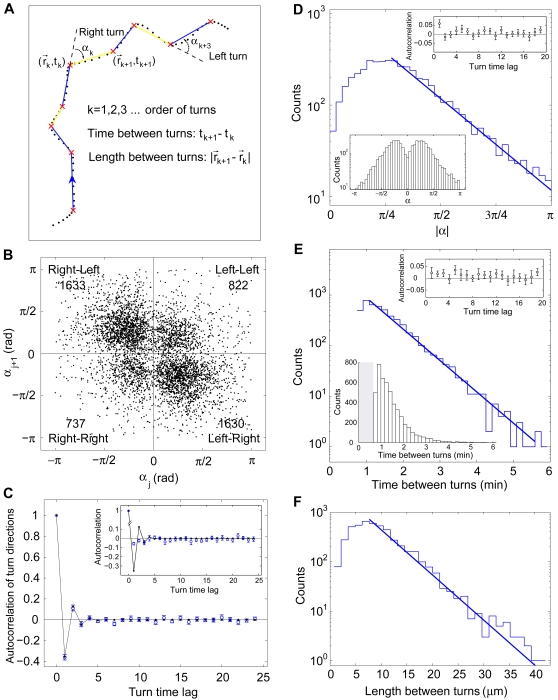
A left turn is followed by a right turn –a Poisson process.(A) Definition of angle of turns (α), direction of turns (left or right), time between turns and length between turns. (B) The jth turn plotted against the (j+1)th turn for the data from all 12 trajectories. There are 3263 data points in the second and fourth quadrant, 1559 in the first and third, and thus the (j+1)th turn is biased by the jth turn by a factor of 2.1. (C) Autocorrelation function for the turn directions (see text for details). Blue: Experimental values and standard errors. Black: Theoretical expectation value for a Markov process with probabilities taken from panel B (see text for details). Insert: Verification that turn-correlations are real and not an artifact of the turn-detection algorithm. Blue: Autocorrelation function for synthetic data. The angle-dynamics was simulated by a worm-like-chain model (WLC) with parameters taken from the MSD of the real data. A small, negative, artifactual correlation is detected which extends for around 3 turns. Black: Same as the main-panel, shown for comparison. (D) Histogram of turn amplitudes. Its tail is well fitted by an exponential distribution (characteristic angle = 0.67 rad). The rounding off at small values is caused by thresholding in the turn-detection algorithm and this sharp cut-off is smoothed by the coarse-graining applied when calculating the angles. Lower left panel: Histogram of α. Upper right panel: Autocorrelation function for turn amplitudes, no correlation was observed. The positive value at time-lag one is a verified artifact of the turn-detection algorithm. (E) Histogram of time intervals between detected turns. These data are well fitted by an exponential distribution (characteristic time = 0.67 min). Data is from all 12 trajectories. Lower left panel: Same histogram but on linear scale. The smallest detected value for tj+1−tj is 40 sec, the cut-off shown by the grey bar. Upper right panel: Normalized autocorrelation function for time between turns. No significant correlations were observed, consistent with a Poisson process. (F) Histogram of length between turns. Its tail is well fitted by an exponential distribution (characteristic length = 5 µm). Distribution of length is trivially exponential if cell averaged speed is constant and times between turns are exponentially distributed.